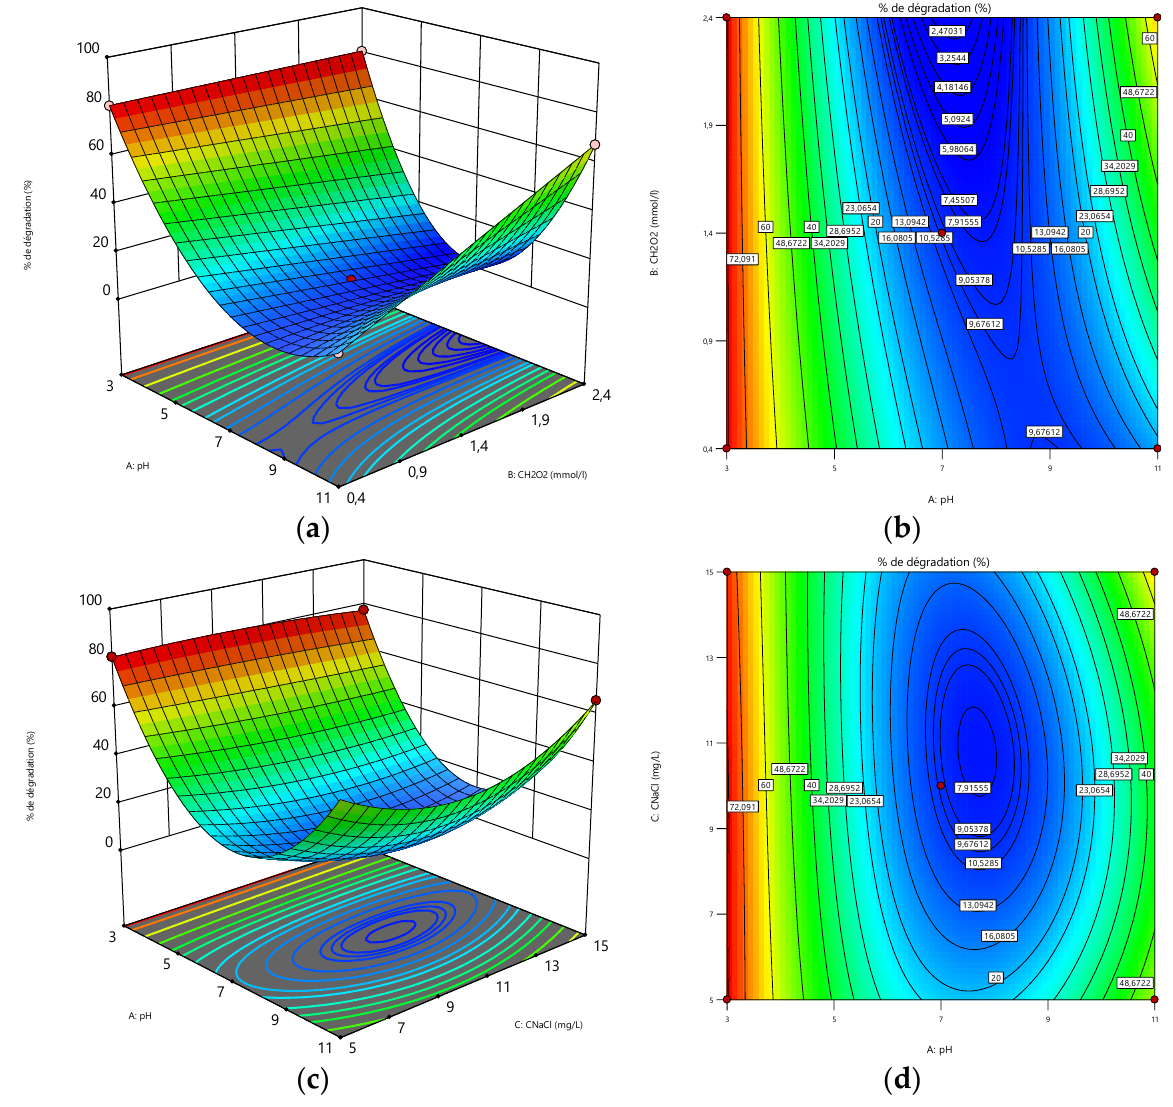
Figure 13. Response surface and contour plots for the mutual effects of pH, C NaCl , and C H 2 O 2 on photocatalytic degradation BPB by TiO 2 /g-C 3 N 4 . The experiments were carried out by addition of 43.5 mM isopropanol (IsoPro), 50 mM methanol (MeOH), and 1.1 mM potassium dichromate (K 2 Cr 2 O 7 ) into a 500 mL BPB (10 ppm) to examine their impact on photocatalytic degradation of BPB with 100 mg/L of